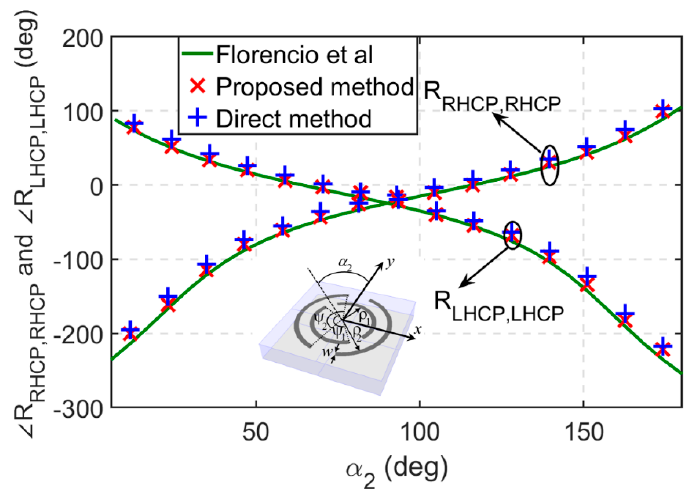
Figure 10. The phase curves shown in Figure 7(a) of [35] and the reproduced results by the proposed and direct methods.